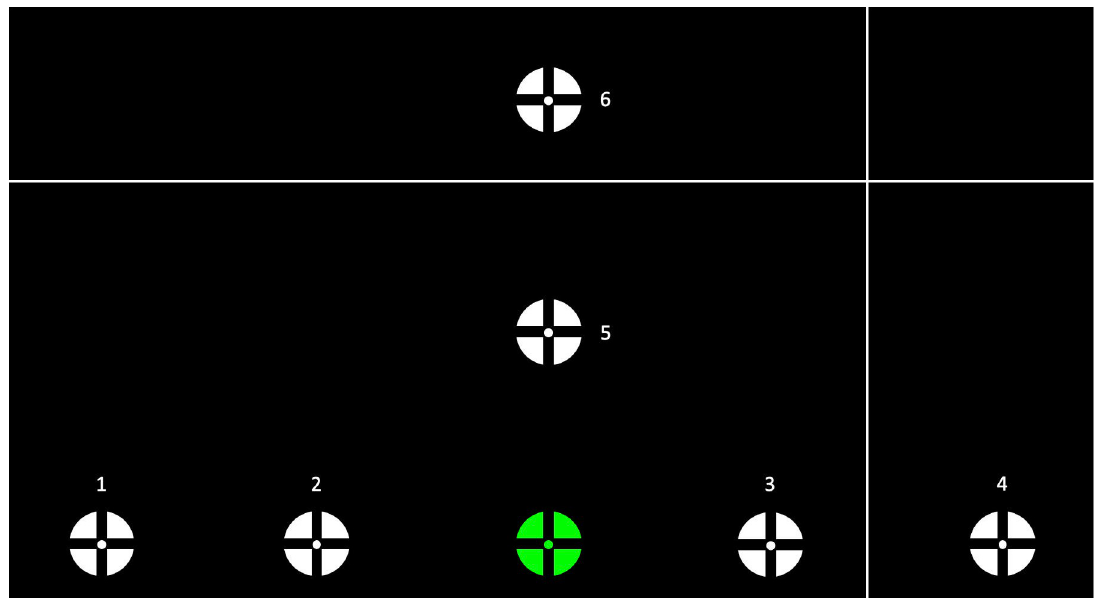
Fig 3. Visual stimuli target array. Distances from the green starting target centers to the center of each white task target were as follows: 1) 24.2 cm, 2) 12.1 cm, 3) 12.1 cm, 4) 24.2 cm, 5) 13.0 cm, and 6) 26.0 cm. Here, the starting target is shown in green, however during the experiment, all targets were white. This figure depicts the locations that the targets would appear on the monitor, as well as an example position of the cross-hair cursor. During the experiment, only one target would be present on the screen at a time.